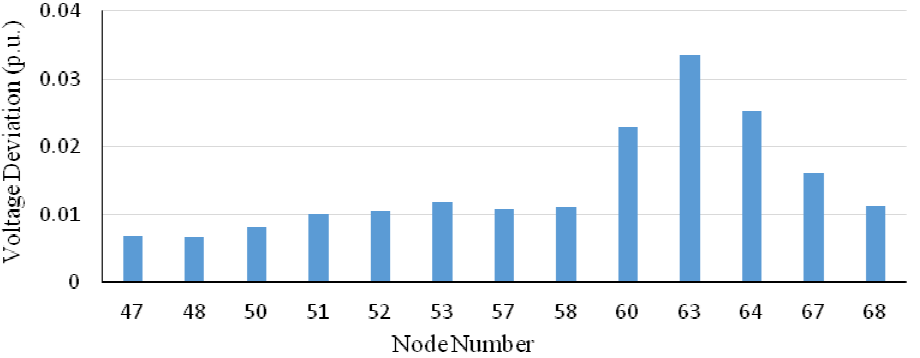
Figure 9. Voltage deviation of the different nodes in zone